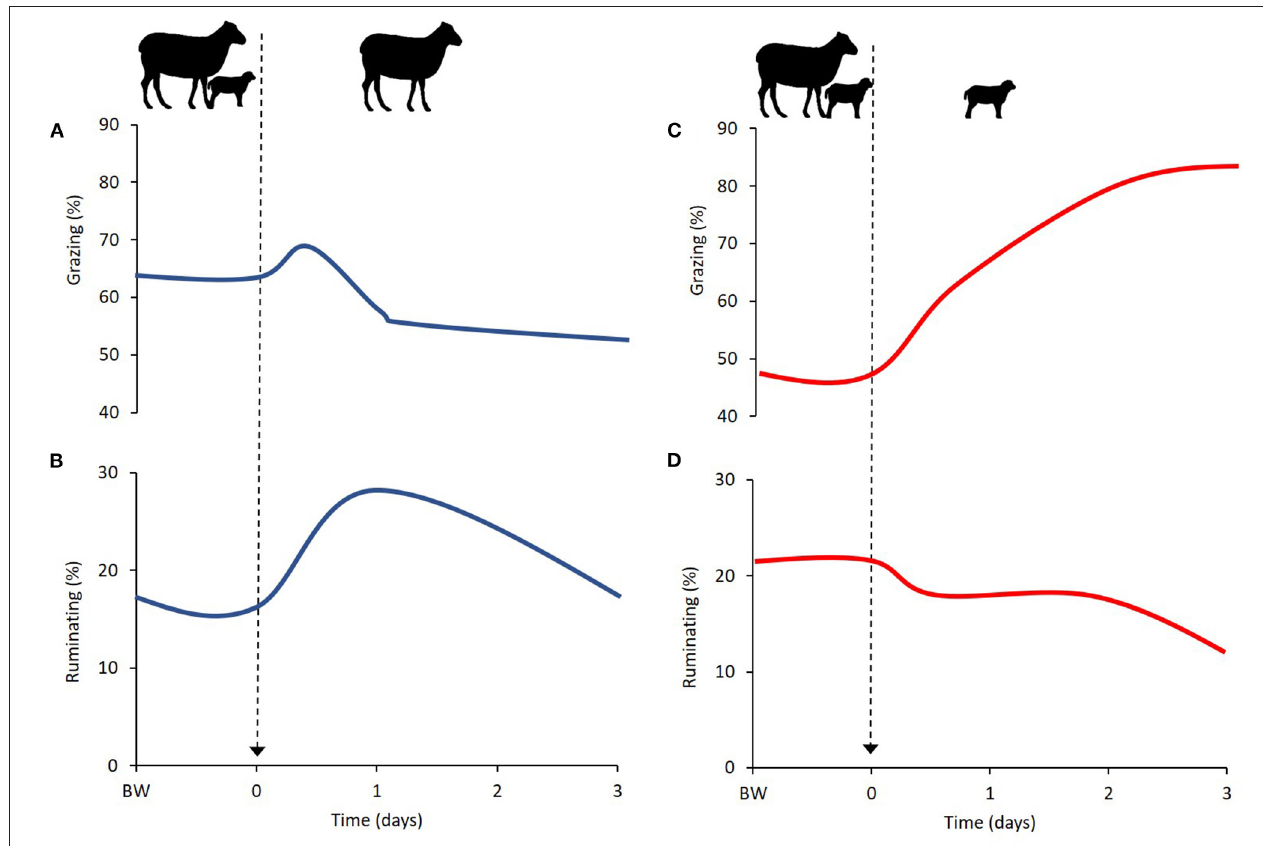
FIGURE 2 | Behavioural changes in ewes (left panel) and lambs (right panel) triggered by weaning (dotted arrow). The upper graphs show the time spent grazing (A,C) and the one below, the time ruminating (B,D) . The models are based in the data of Freitas-de-Melo and Ungerfeld